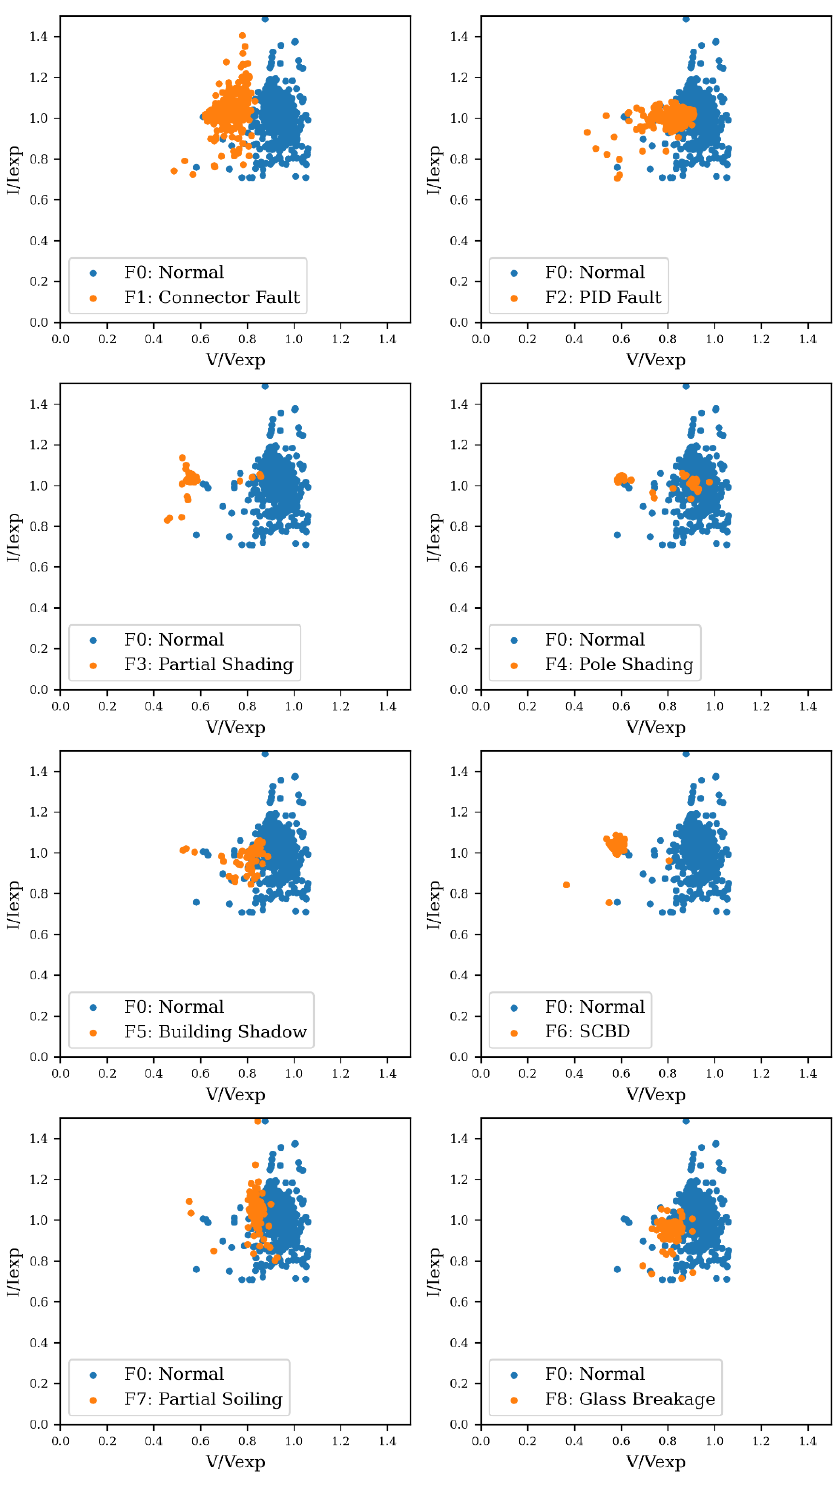
Figure 6. Normalized PV module current vs. voltage for various faults compared to the normal con- dition.